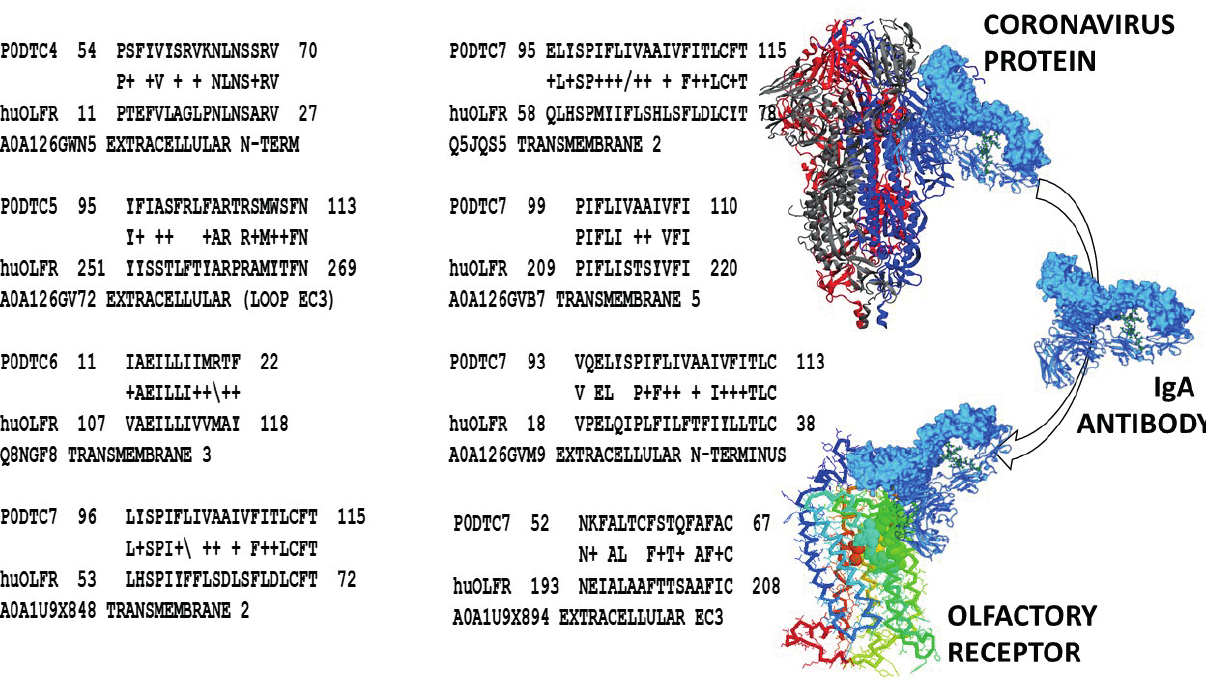
Figure 1. Left: Representative similarities between SARS-CoV-2 proteins and human olfactory receptors (huOLFR). + signs indicate homologous amino acid substitutions. Full SARS-CoV-2 protein names are provided in the Table. The UniProt accession number for the particular human olfactory recep- tor is provided below each match. However, note that all of these similarities were repeated up to fifty times in other olfactory receptor homologs indicating that the similarities are mainly to highly conserved receptor regions so that antibody against any one olfactory receptor has a good prob- ability of binding to others as well. Note also that the location of the similarity on the olfactory receptor molecule is provided; additional similarities exist to extracellular, transmembrane and cytoplasmic regions of the huOLFR that are not shown. Those similarities that are extracellular or trans- membrane are the most likely to be accessible to antibody and are also the regions most likely to interfere with odorant binding and the changes in receptor conformation required to transmit a binding signal. Right: A visual summary of the hypothesis proposed here that some IgA (and possibly IgG or IgM) antibodies elicited by SARS-CoV-2 and other coronaviruses may cross-react with olfactory receptors because of the similarities illustrated to the left. Antibody binding to the olfactory receptors blocks odorant binding and/or signaling as long as antibody titers are sufficiently